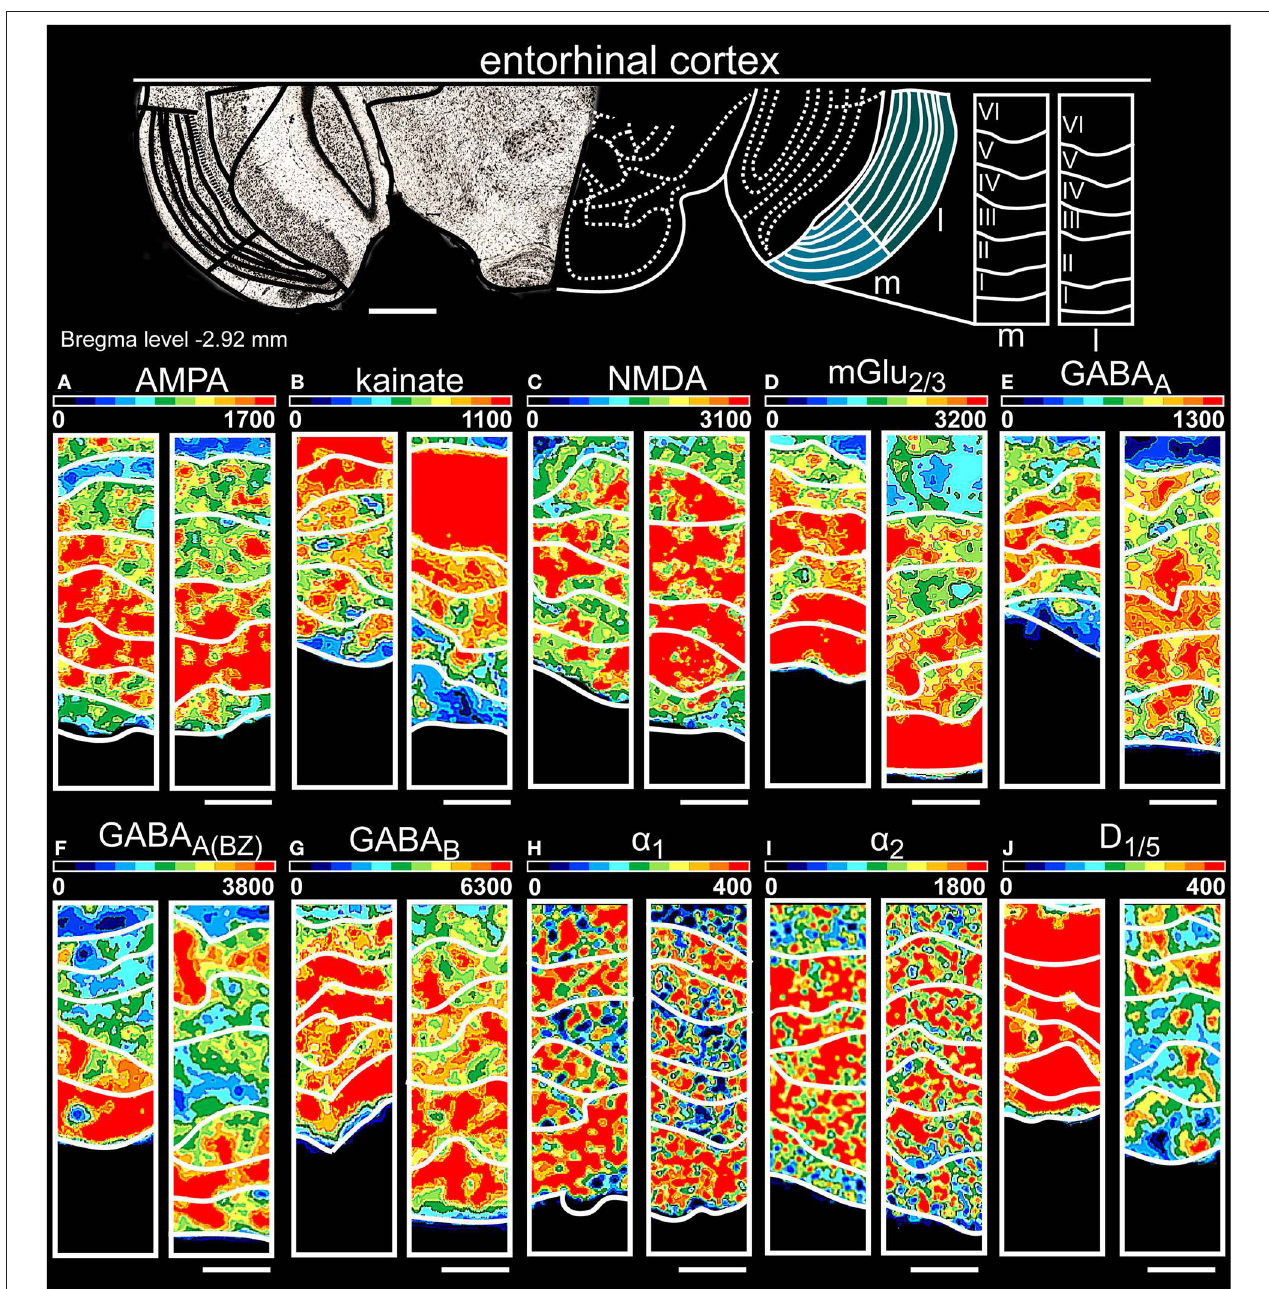
FIGURE 8 | Color-coded autoradiographs showing the distribution and density of all investigated receptors of the entorhinal cortex ( l , lateral; m , medial). Densities of the color-coded autoradiograms in fmol/mg protein according to color scales. For detailed receptor densities see Table 1 . Scale bars: Atlas, 1.5mm; (A–J) , 200 µ m.